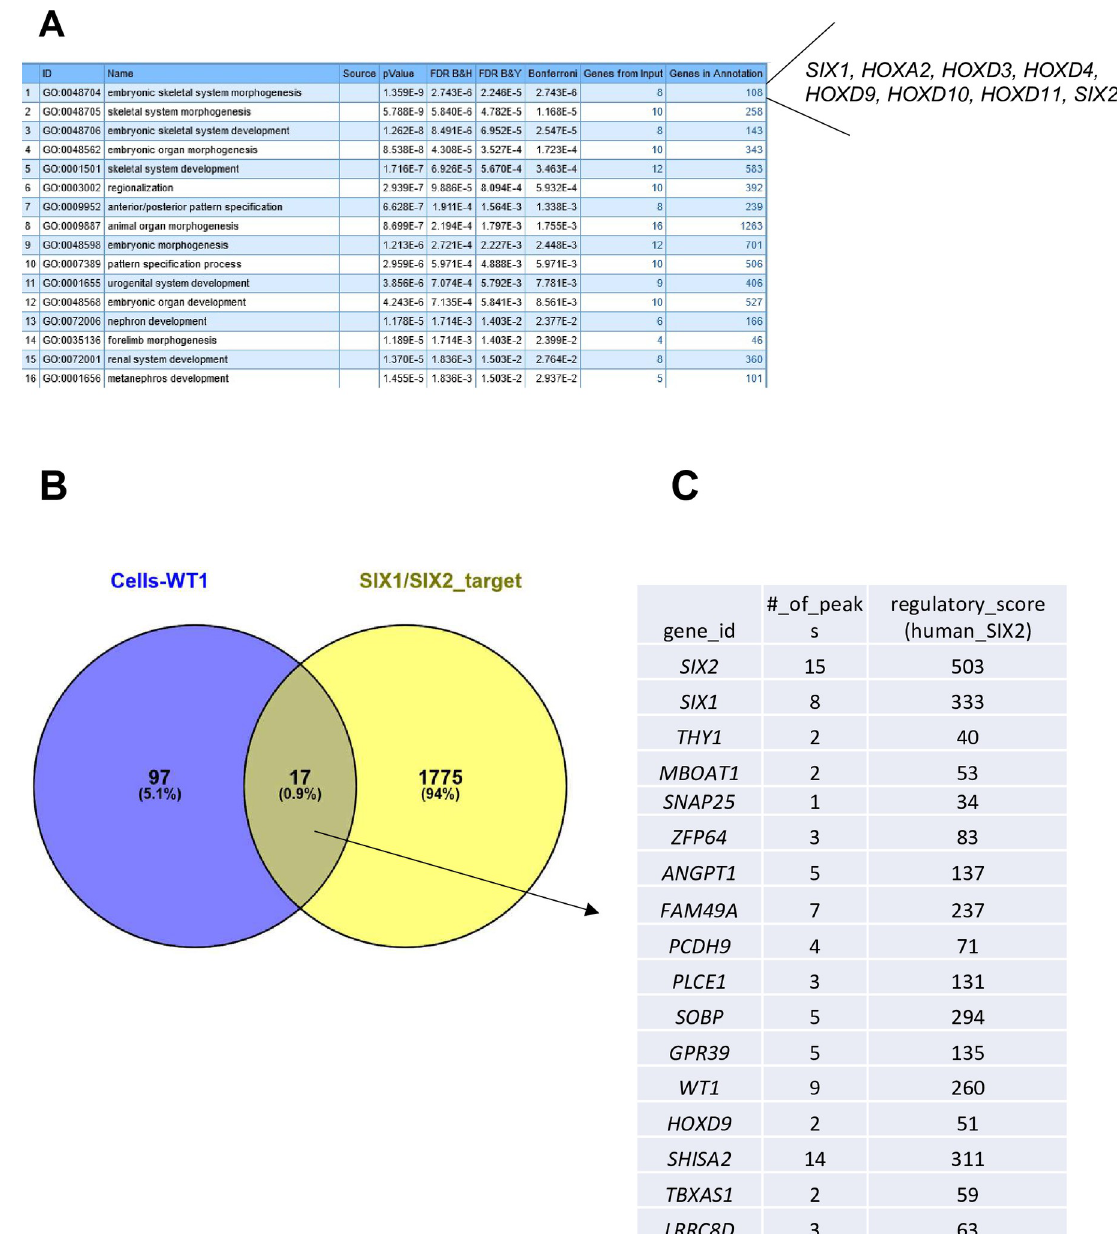
Fig 11. Analysis of differentially expressed genes in Wilms cells with and without mutant WT1 expression. A) ToppGene result for the differentially expressed genes. B ) The Venn diagram shows that among the 114 differentially expressed genes in cells with and without WT1 (blue circle) 17 are putative SIX1/2 target genes (yellow circle, 1792 putative SIX1/2 target genes identified by O´Brien et al., 2016 [14]. C) A list of the 17 putative target genes with the number of peaks as detected with ChIP seq by O´Brien et al., 2016 and the regulatory score that they have determined